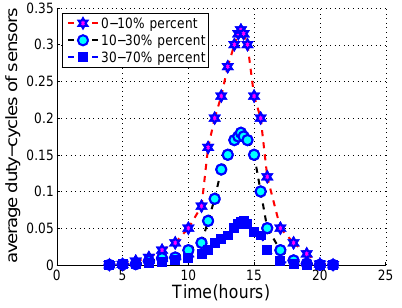
Figure 2. A solar powered sensor is deployed in outdoor.